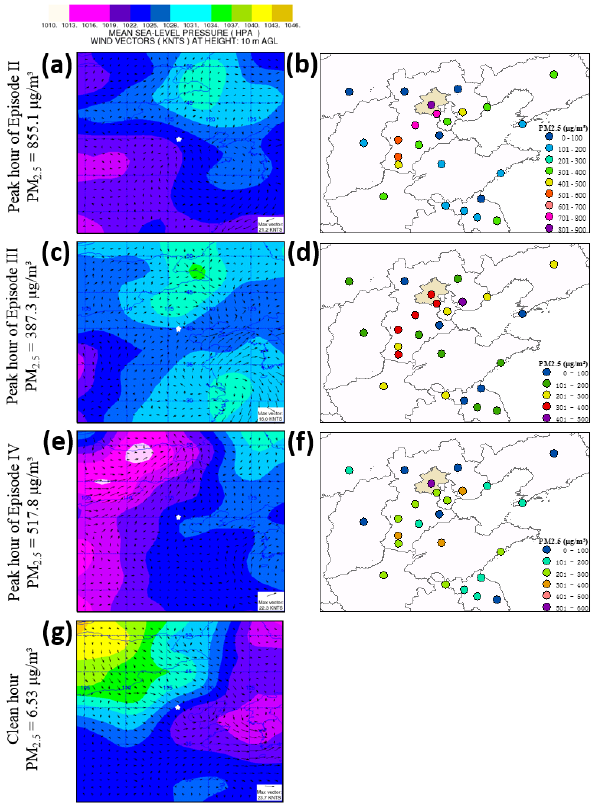
Figure 4. Surface weather maps (a, c, e, g) and PM 2 . 5 concentra- tions (b, d, f) of the North China Plain on 12 January LT 18:00 (a, b) , 18 January LT 20:00 (c, d) , 29 January LT 13:00 (e, f) , and 1 January LT 08:00 (g) . The location of Beijing is indicated as a white star on the weather maps, and as the shaded area on the PM 2 . 5 concentration maps. PM 2 . 5 concentrations in Beijing at the four se- lected time points are also shown on the left for